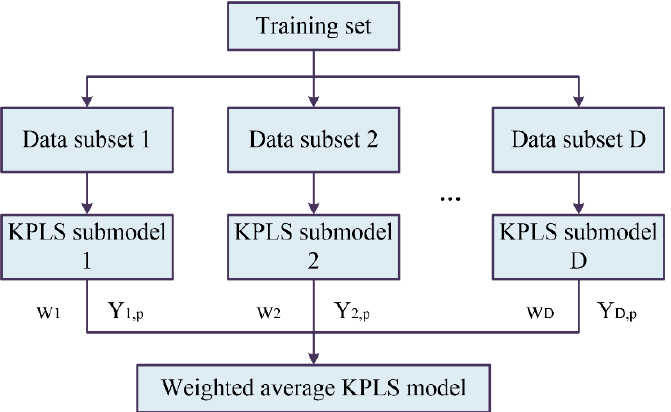
Figure 3. Establishment of the weighted average kernel partial least squares (KPLS) model.